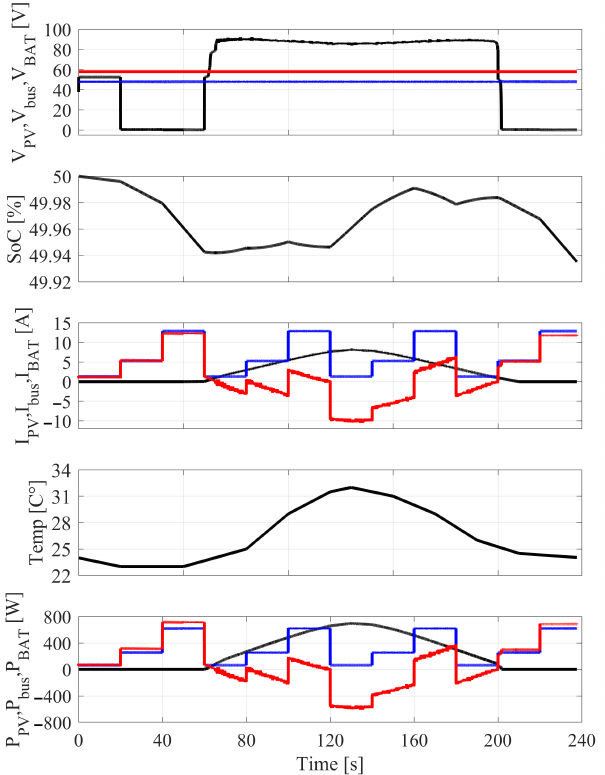
Figure 22. Simulation results in summer standard conditions for Parma, 44 ◦ 45 (cid:48) 53 (cid:48)(cid:48) N 10 ◦ 18 (cid:48) 26 (cid:48)(cid:48) E,